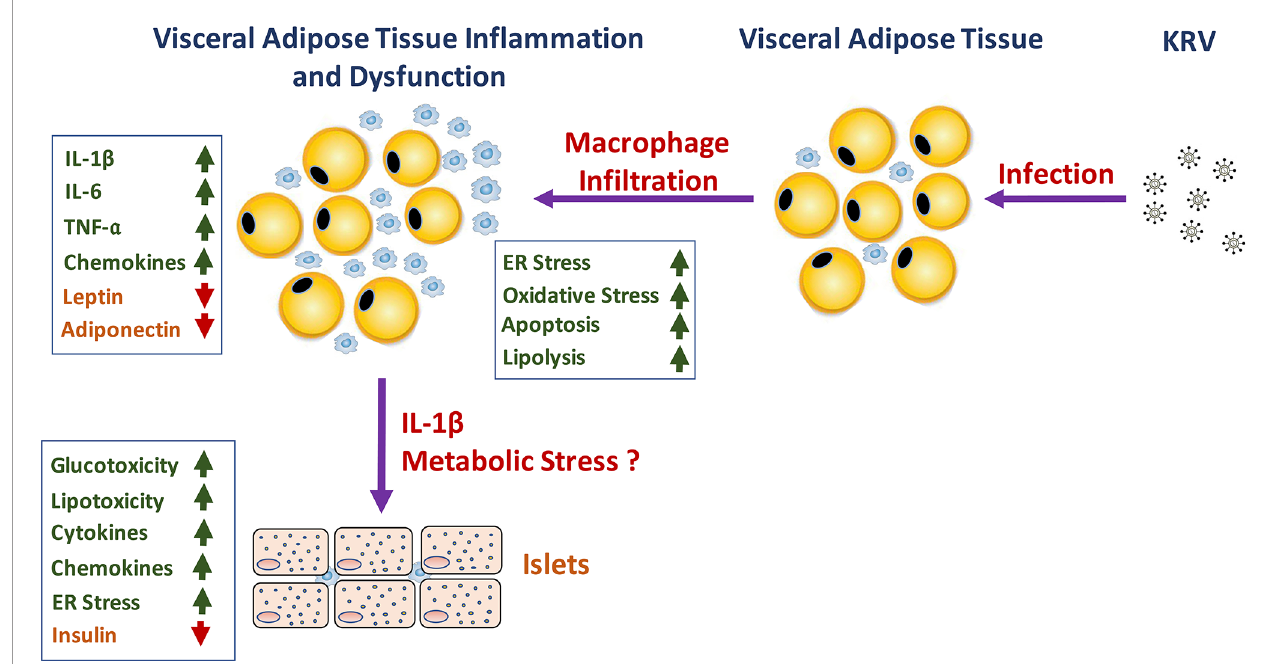
FIGURE 1 | A schematic representation of the hypothesized role of KRV-induced VAT in fl ammation and dysfunction in the mechanism of KRV-induced